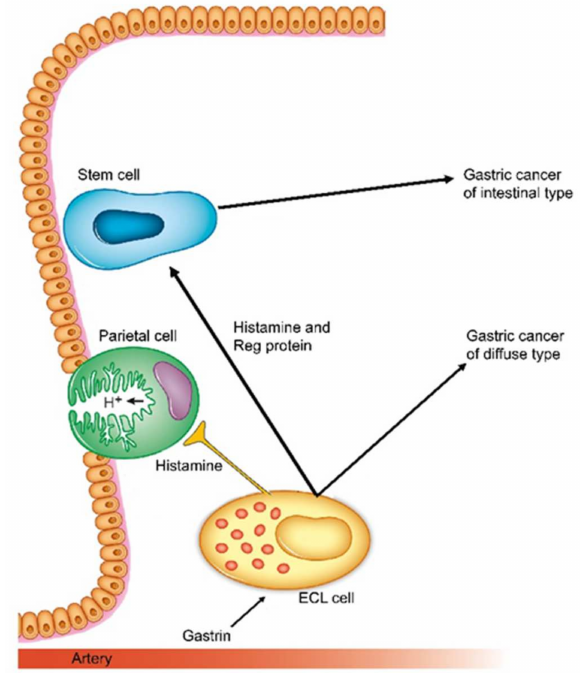
Figure 3. Schematic presentation of how gastrin and its target cell, the ECL cell are central in carcinogenesis both for intestinal and diffuse types (With permission from ref [78]).